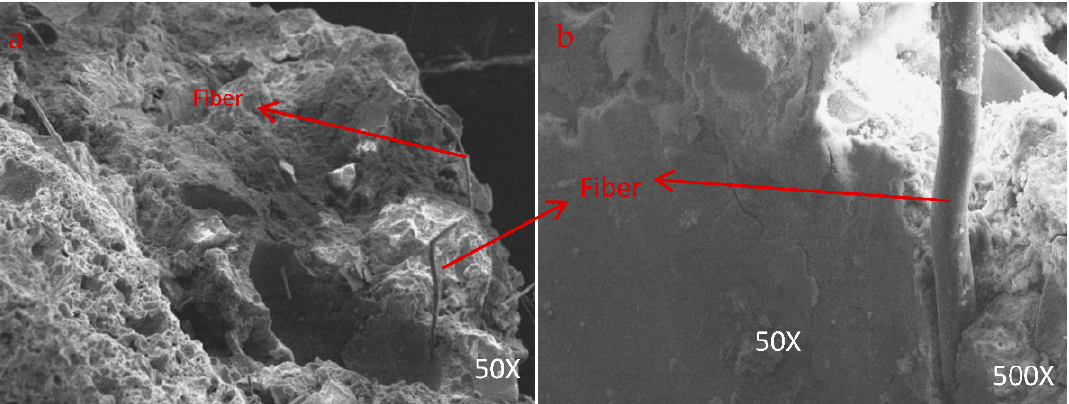
Figure 9. ( a ) Bonding interface of 12 mm basalt fiber and cement matrix at 50X; ( b ) Bonding interface of 12 mm basalt fiber and cement matrix at 500X.